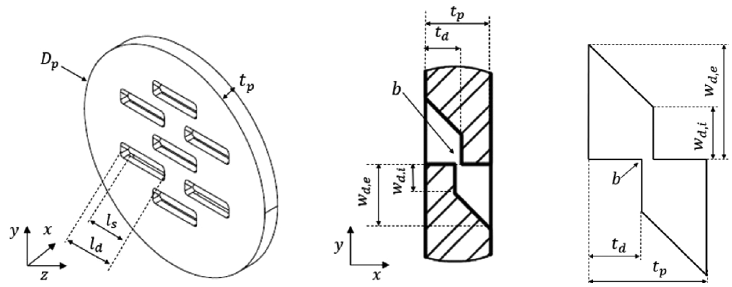
Figure 3. Sketches of the plate and of the cross-section of a single slit with